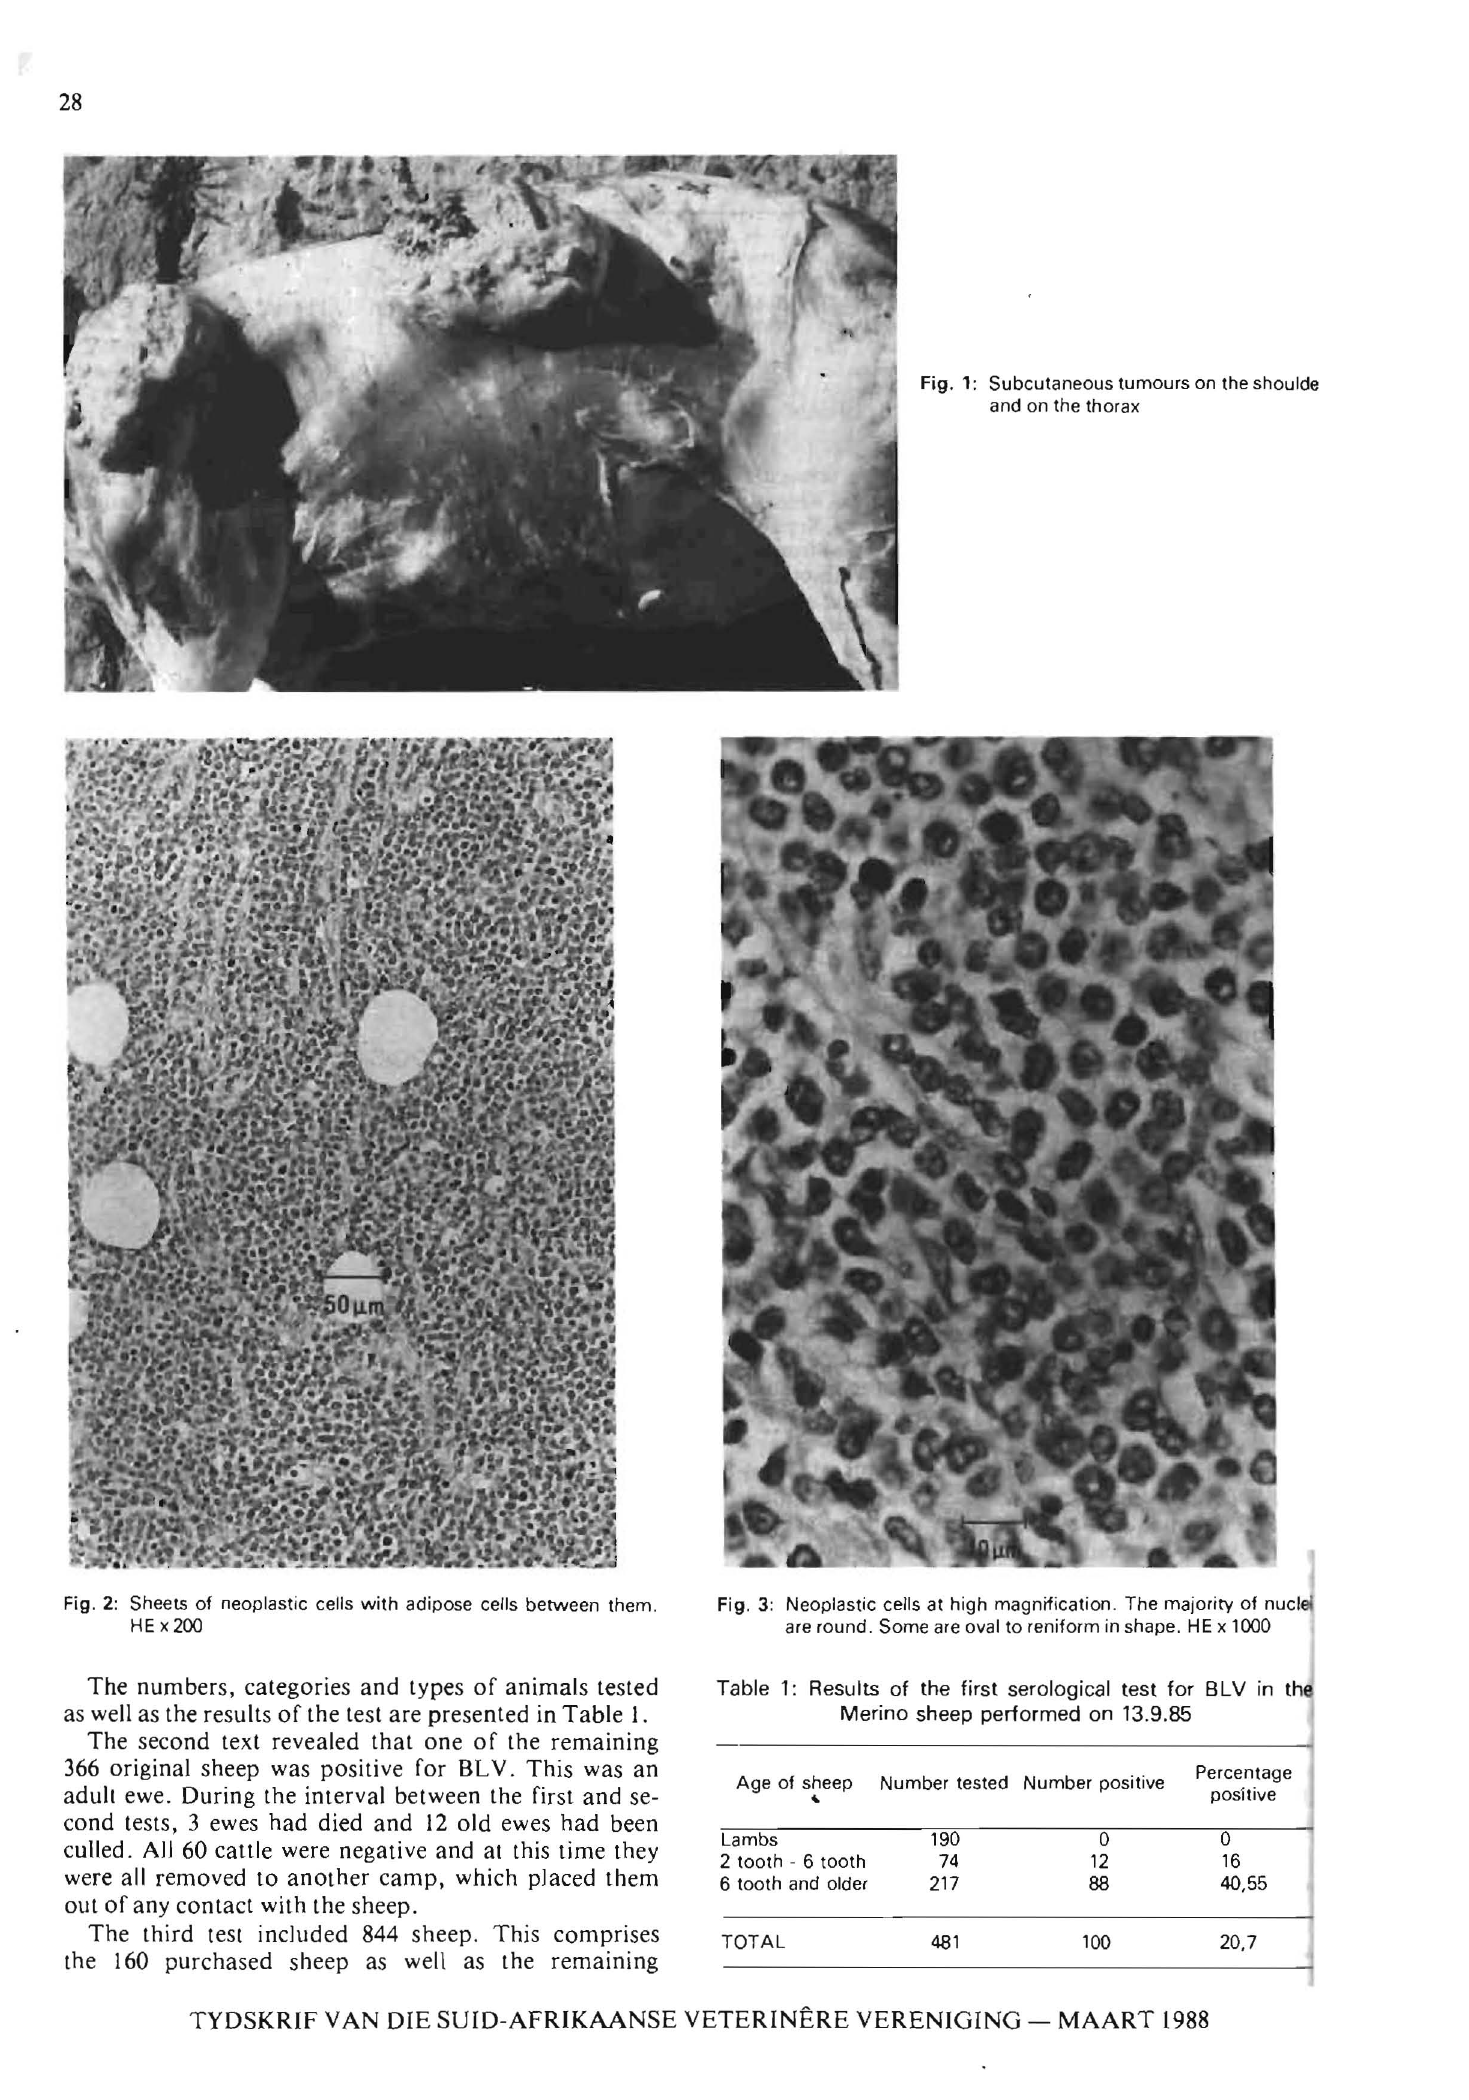
Fig. 1: Subcutaneous tumours on the shoulde and on the thorax